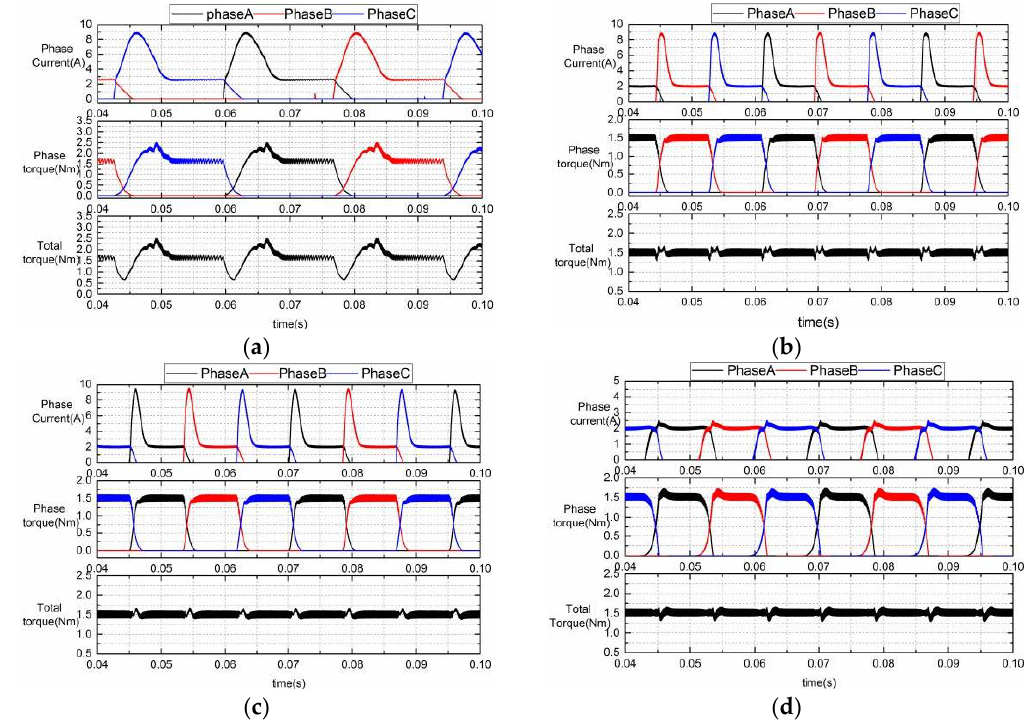
Figure 11. Simulation results ( T ref = 1.5 Nm, 1000 rpm): ( a ) current chopping control (CCC); ( b ) Linear TSF; ( c ) Sinusoidal TSF; ( d ) TSF1 ( r = 4).